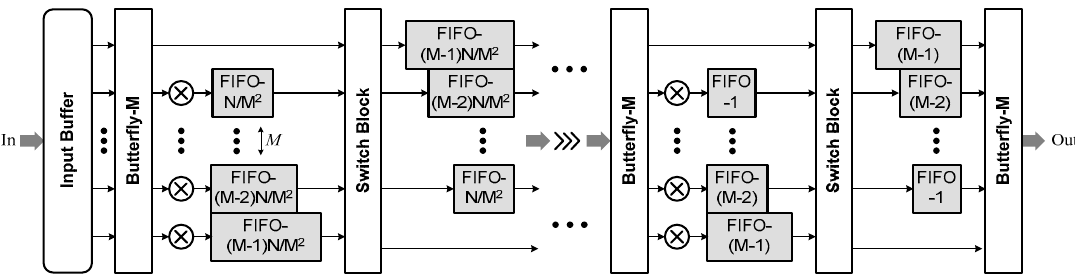
Figure 3. Block diagram of conventional M -path MDC fast Fourier transform (FFT) architecture for M-stream MIMO-OFDM.